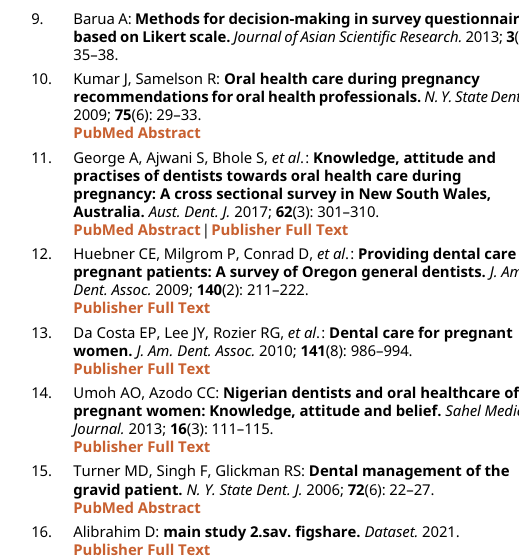
Figshare: main study 2.sav, https://doi.org/10.6084/m9.figshare.17197283.v2. 16